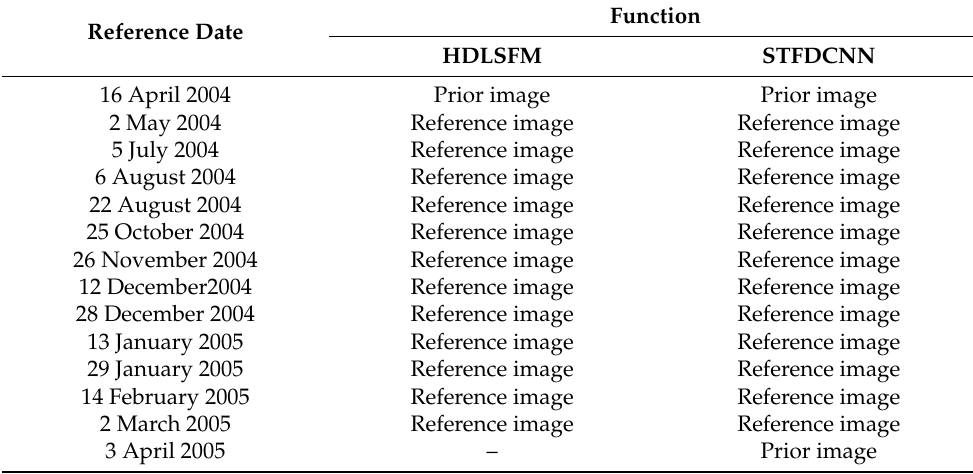
Table A1. Functions of Landsat images in the LGC